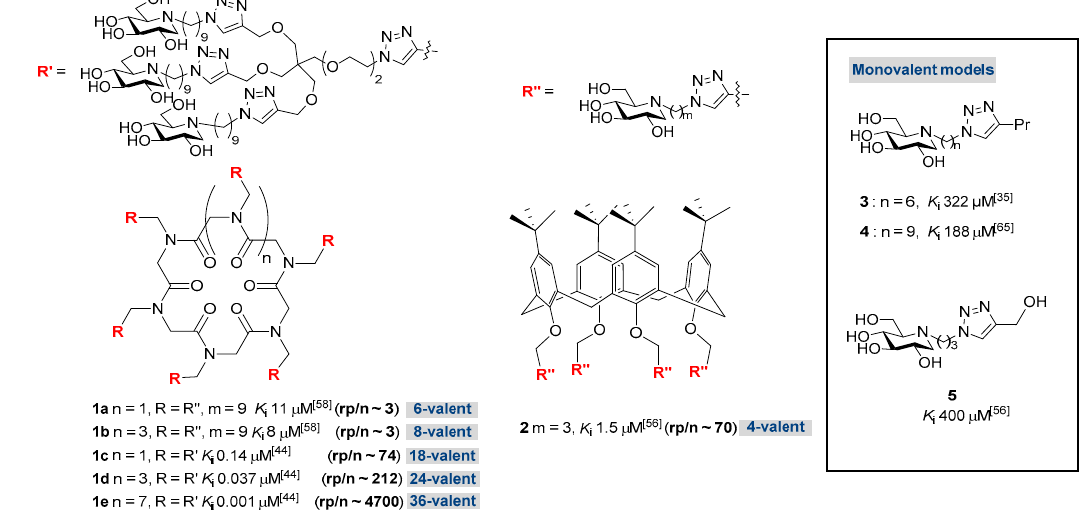
Figure 1. Structure and inhibition constant against Jack Bean α -mannosidase of multivalent clusters and their monovalent references.